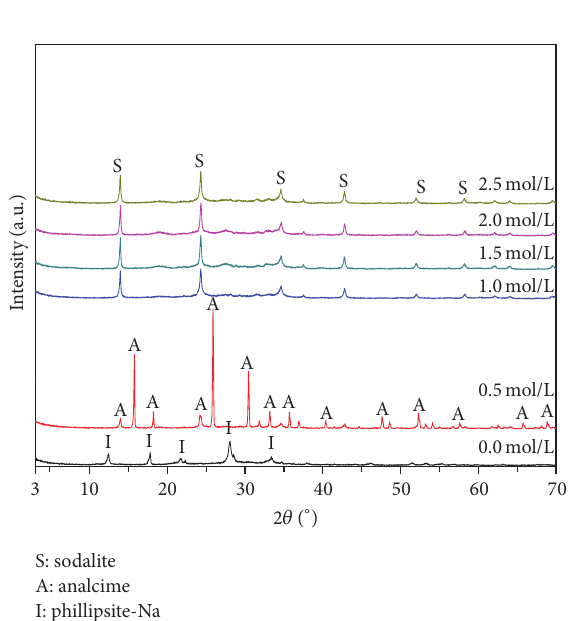
Figure 3: XRD patterns of products prepared under different NaOH